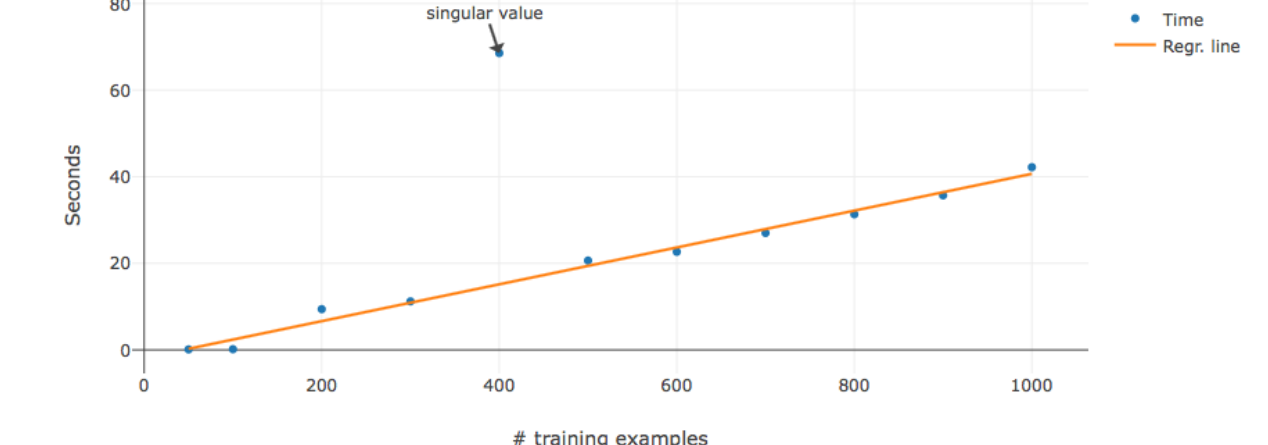
Figure 20. Time for training an SVC.